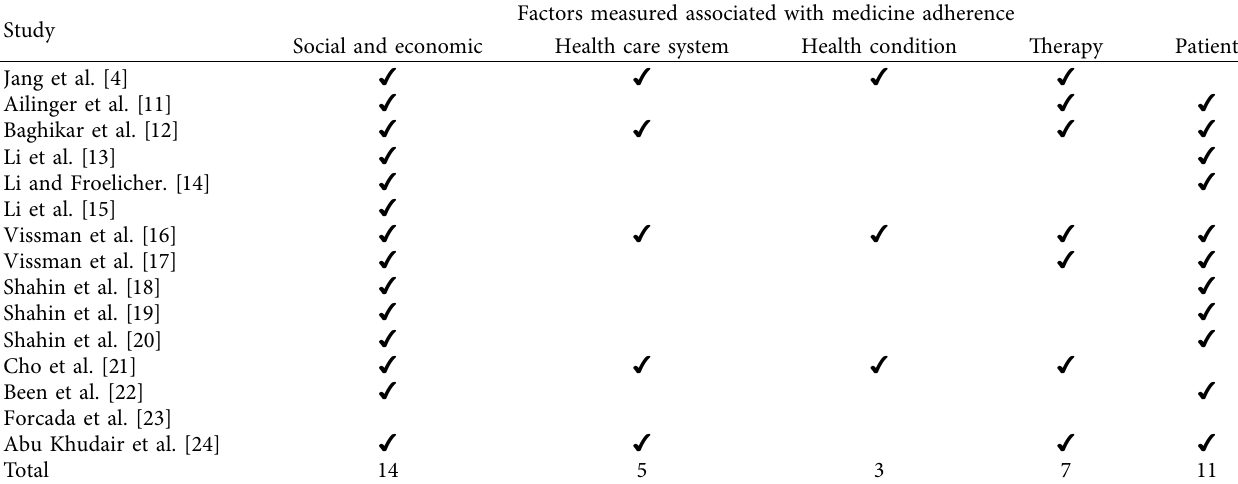
Table 4: Factors measured associated with medicine